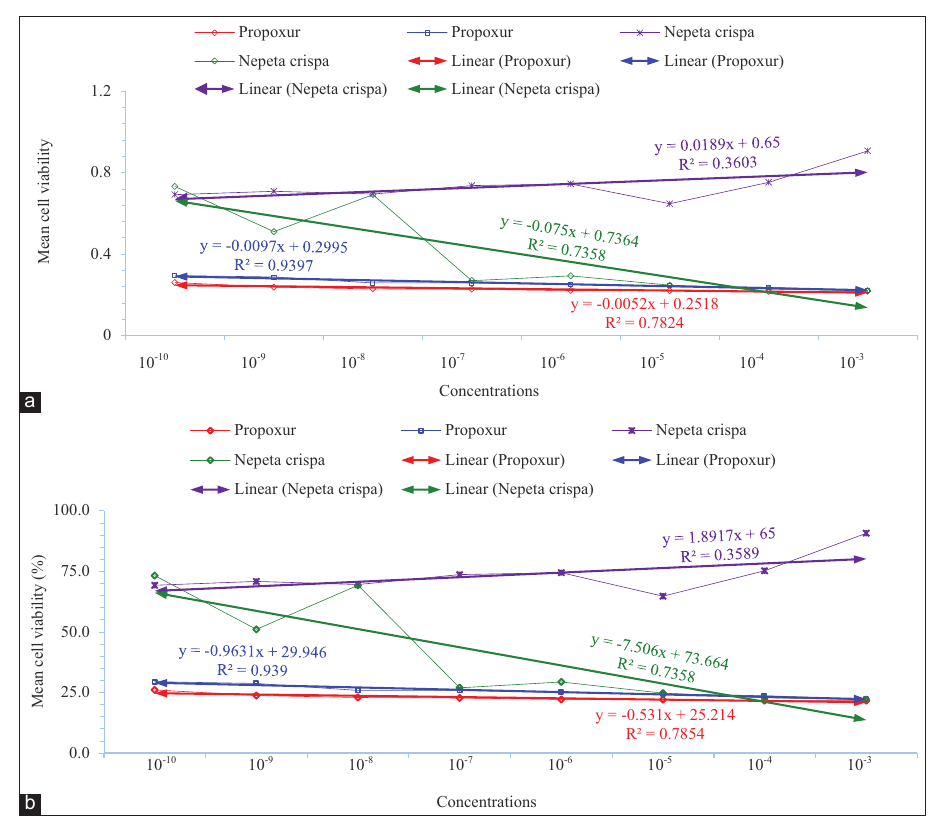
Figure-3: Cytotoxicity trend lines of Nepeta crispa essential oil (ng/μL) and propoxur (μg/μL) against invertebrate (Sf9) and vertebrate (L929) cell lines. (a) Normal data and (b) percentage. The trend lines were drawn by clicking on graph line distribution and selecting “add trendline” option. Cell line of Sf9 derived from the ovary gland of the fall armyworm, Spodoptera frugiperda (Smith) (Lepidoptera: Noctuidae). Cell line of L929 derived from mouse fibroblast cells.